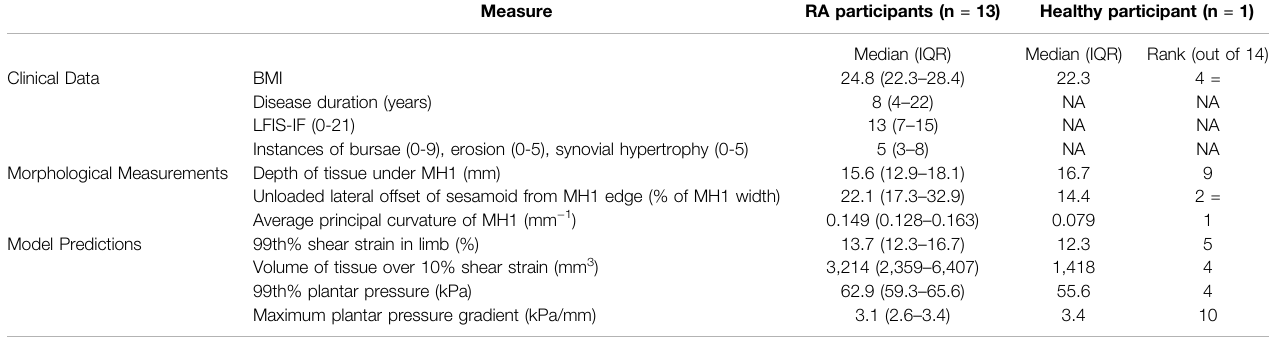
TABLE 2| Median(IQR) resultsfortheclinicaldata,morphologicalmeasurementsand model predictions. The healthyparticipantrank indicates wherethey fellwithintheRA dataset, with one being lowest and 14 highest. X (cid:2) denotes where rankings where tied.